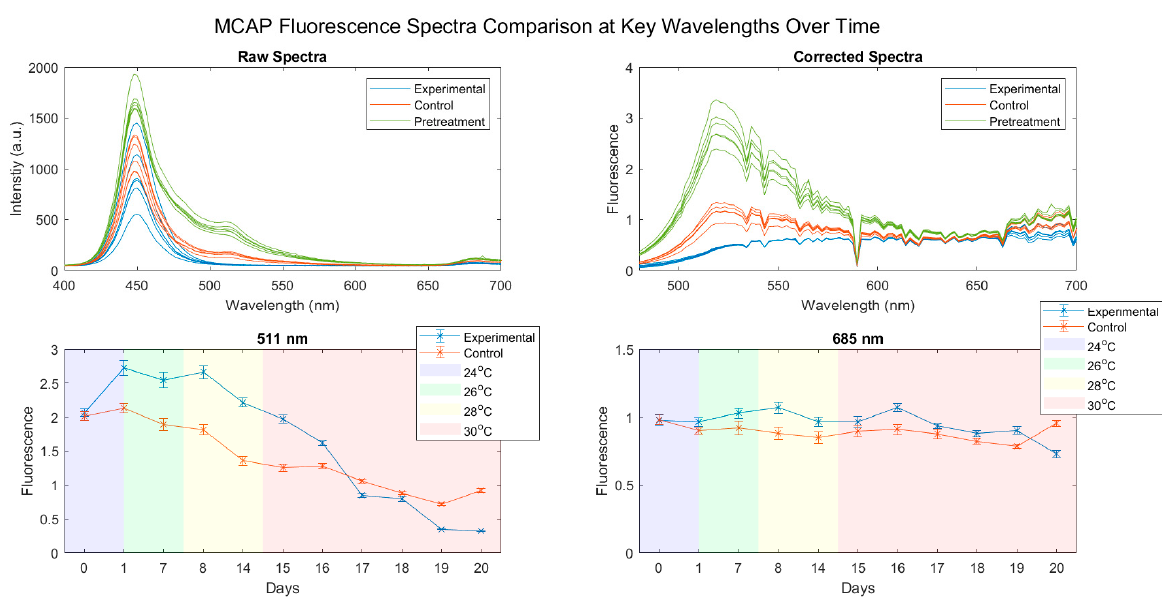
Figure 4. Raw & corrected fluorescence spectra and reflectance of key wavelengths of Montipora capricornis (MCAP) over time imaged under royal blue (440 nm) light in experiment 1. The average intensity at each wavelength per day of treatment is presented, where the temperature regime is represented as the blue section corresponding to 24 °C (the control stayed at this temperature throughout), green to 26 °C, yellow to 28 °C and red to 30 °C.